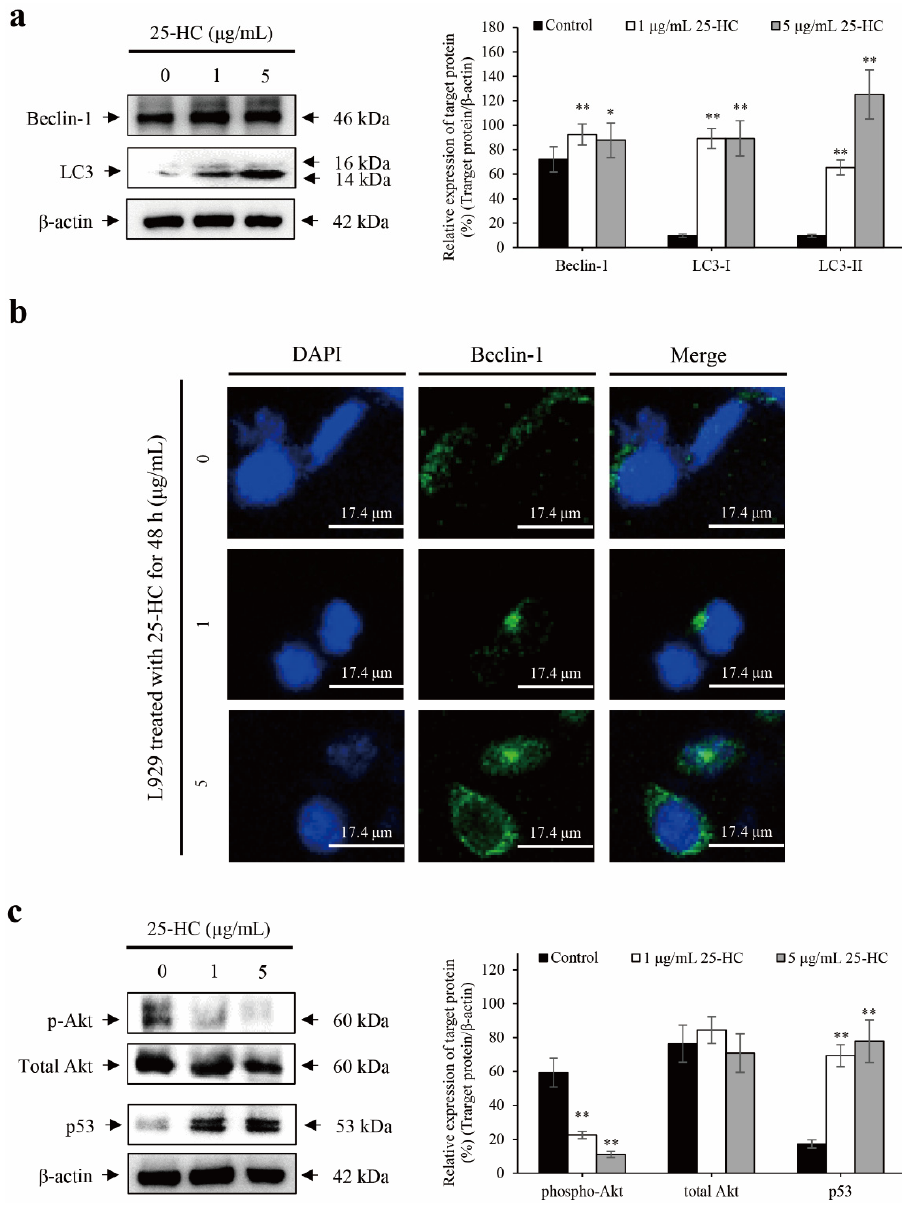
Figure 7. 25-HC-induced apoptosis was accompanied by p53-dependent autophagy through the suppression of Akt phosphorylation in L929 cells. L929 cells were treated with 1 and 5 µ g/mL 25-HC for 48 h. Thereafter, Western blot ( a ) using autophagy biomarkers such as beclin-1 and LC3, immunocytochemistry ( b ) using beclin-1 antibody and DAPI for staining nuclei and Western blot ( c ) using antibodies of cellular signaling molecules associated with autophagy such as Akt and p53 were performed to investigate 25-HC-induced autophagy and the underlying cellular signaling pathways in L929 cells. ( a ) Treatment with 25-HC caused an increase in the expression of autophagy biomarkers such as belcin-1 and LC3 in L929 cells. ( b ) There was an increase in the expression of beclin-1 in L929 cells treated with 25-HC. ( c ) 25-HC not only decreased the phosphorylation of Akt, but also increased the expression of p53 in L929 cells. The results of Western blot were expressed as the relative ratio of target protein/ β -actin, * p < 0.05 and ** p < 0.01. β -actin was used as the internal control.